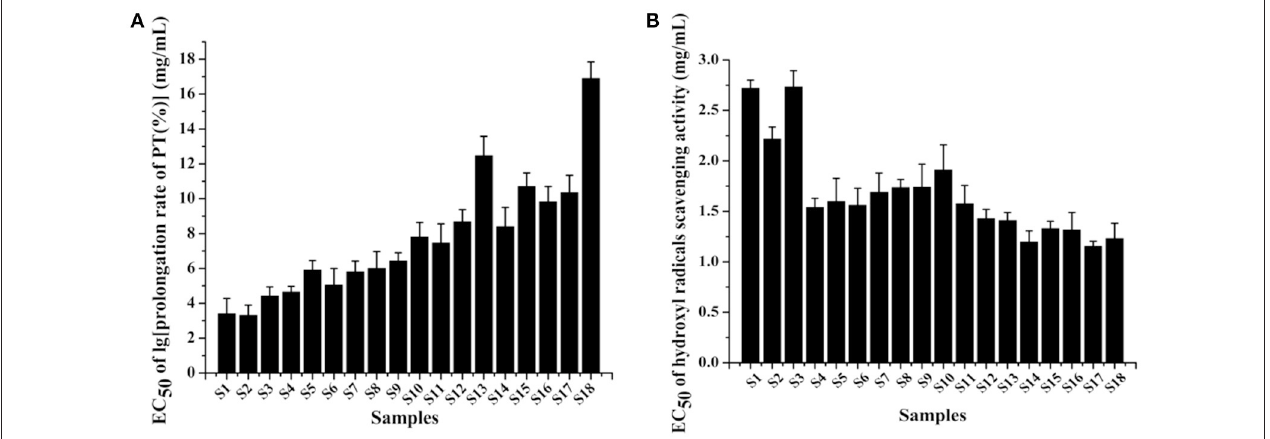
FIGURE 3 | The anticoagulation activity (A) and antioxidation activity (B) of 18 batches of Panax notoginseng (PN) samples.